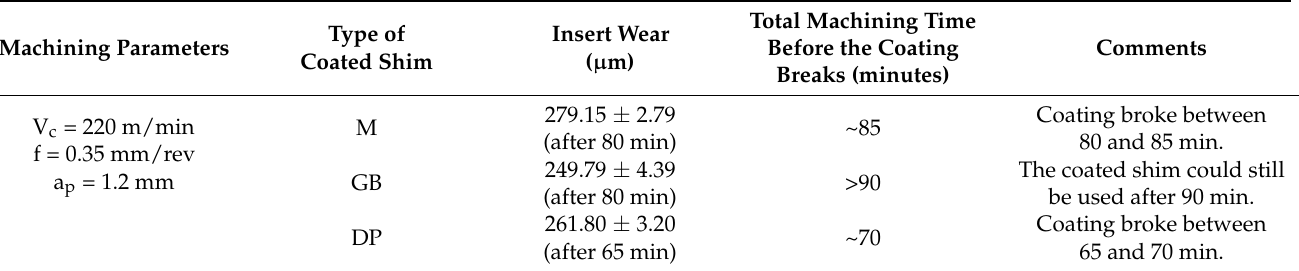
Table 7. Machining test results. Five wear measurements were taken for each insert.